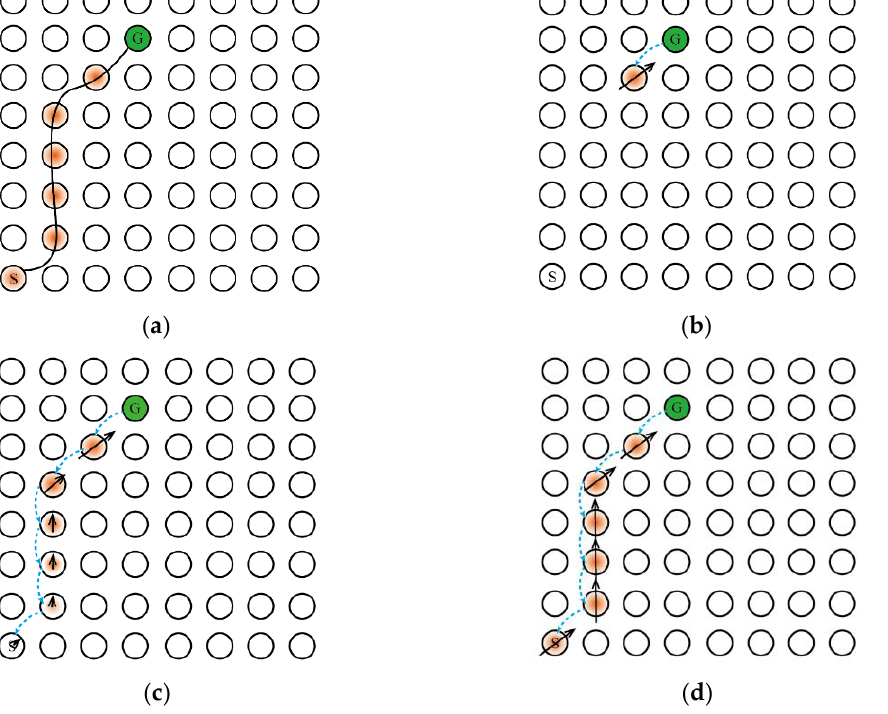
Figure 5. The Memory-Replay Mechanism can replace qualification tracking without parameter tuning. The direction of the black solid arrow represents the action selection made by the agent to obtain the corresponding reward information, and the length represents the information amount of the reward signal returned from the previous state; the blue dashed arrow represents the transmission direction of the reward information between the place cells. ( a ) The optimal path trajectory found by the agent. ( b ) Reward signaling in the absence of qualification tracking. ( c ) Reward signaling with qualification tracking, parameter λ < 1, the amount of information transmitted back to the reward signal from the previous state decays exponentially. ( d ) Reward signaling by Memory-Replay Mechanism, that is, with qualification tracking, parameter λ = 1. The return of the reward signal from the previous state has no loss throughout the trajectory (under ideal conditions).